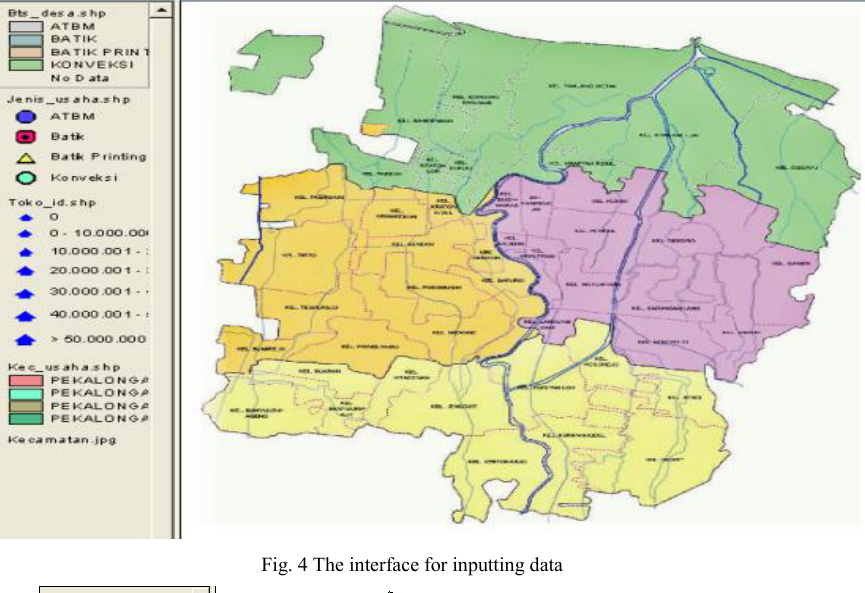
Fig. 4 The interface for inputting data